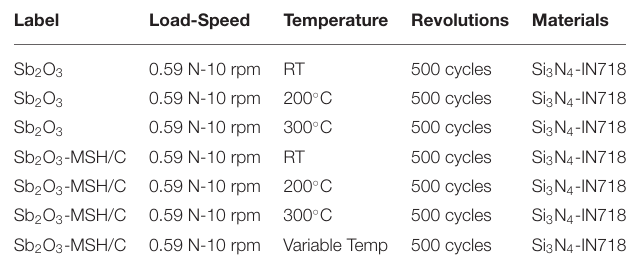
TABLE 1 | The experimental details.